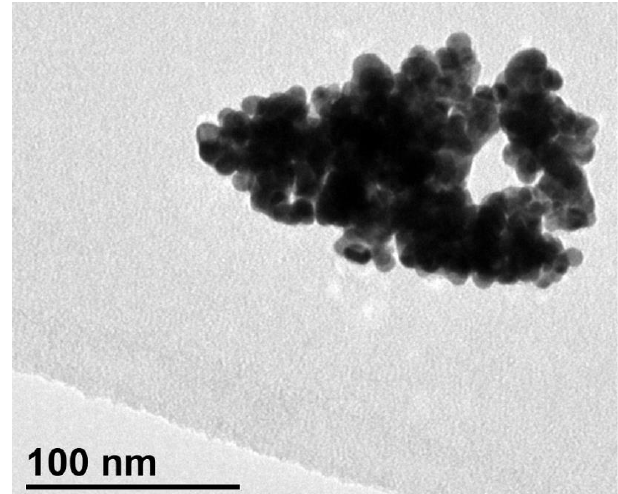
Figure 3. Zero-valent gold.